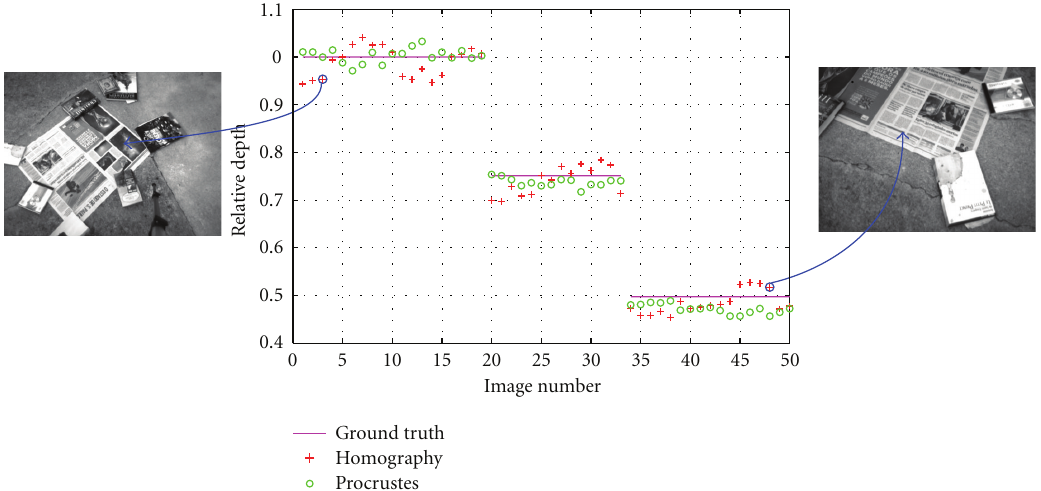
Figure 6: Relative heights to the ground for the tripod experiment, with two example images. Each unit on the abscissa corresponds to one image. Images were taken from 3 di ff erent heights.